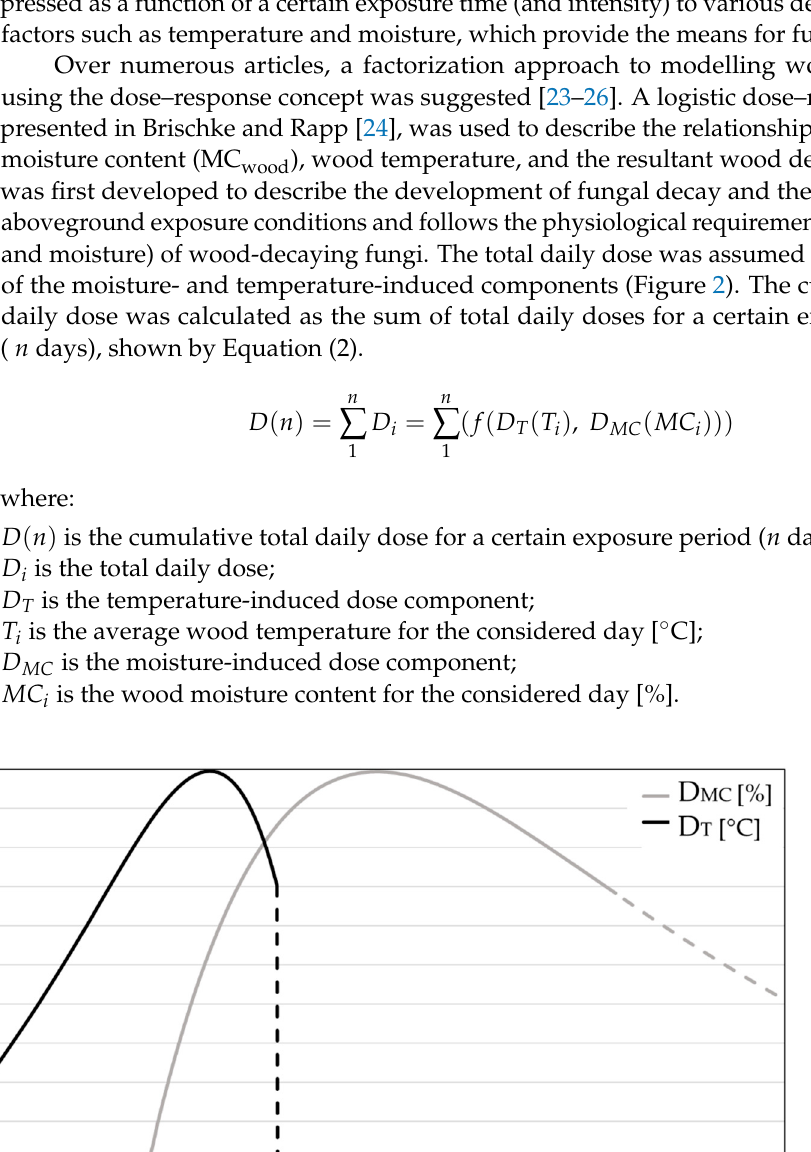
(𝑇 ), 𝐷 (𝑀𝐶 (cid:3021) (cid:3036) (cid:3014)(cid:3004)